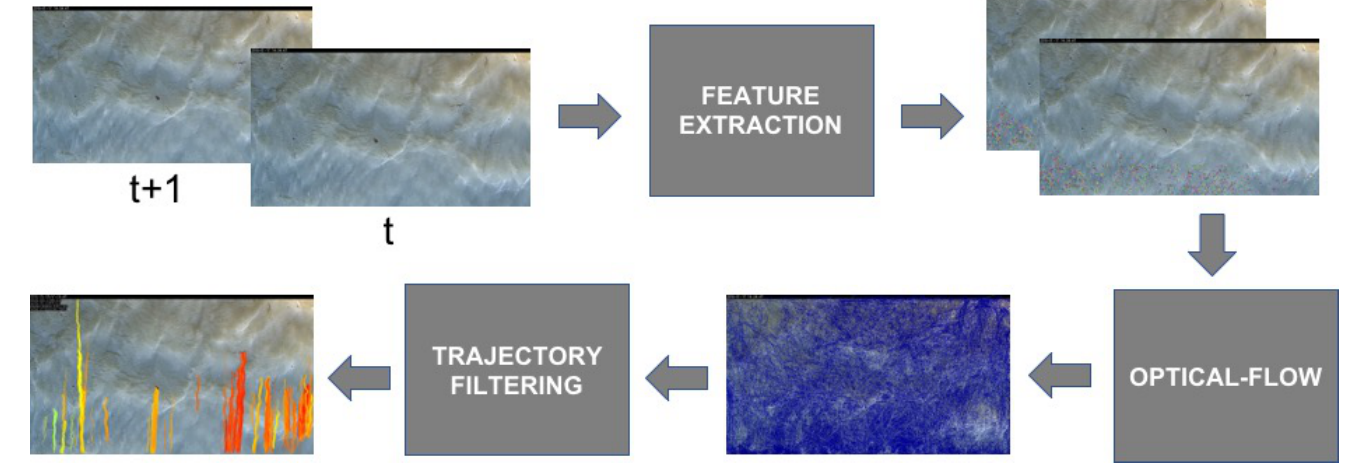
Figure 2. Description of the OTV algorithm